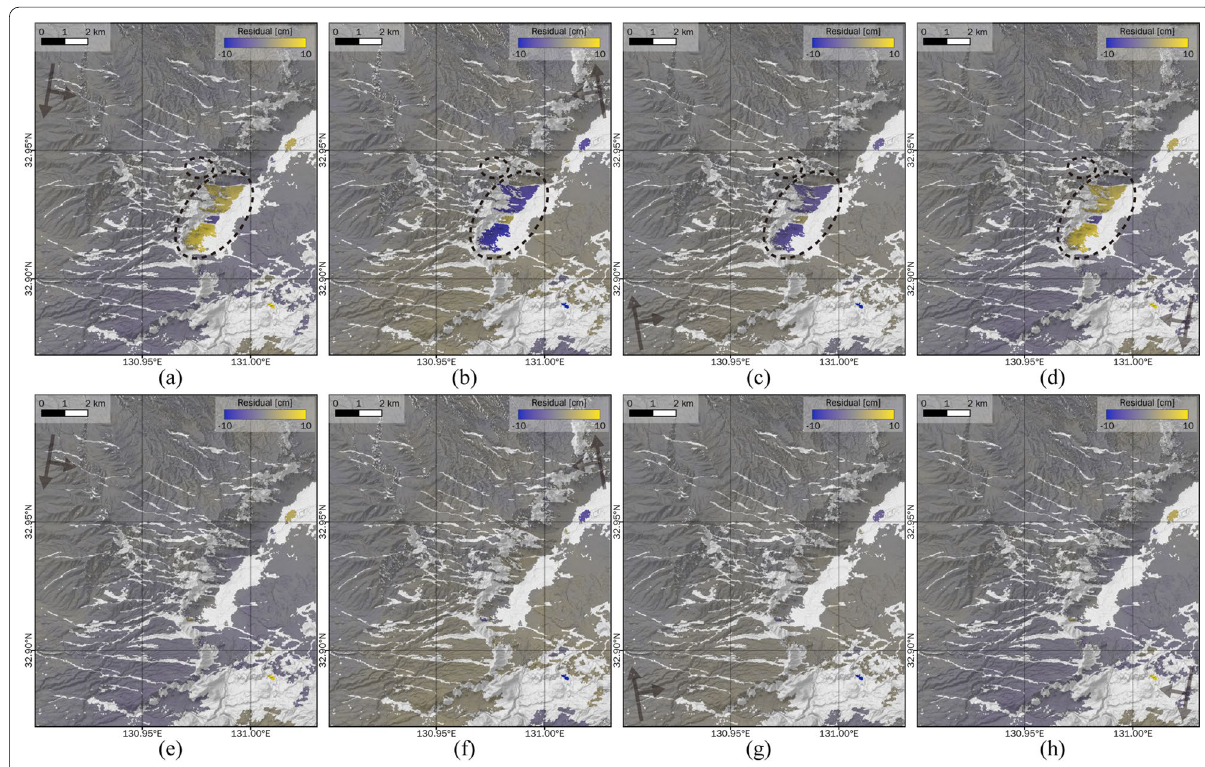
Fig. 10 Residuals from the 3D decomposition. a – d Before unwrapping error corrections. e – h After unwrapping error corrections. Ellipses with black dashed lines in a – d denote isolated components containing unwrapping errors. a , e Descending left-looking. b , f Ascending left-looking. c , g Ascending right-looking. d , h Descending